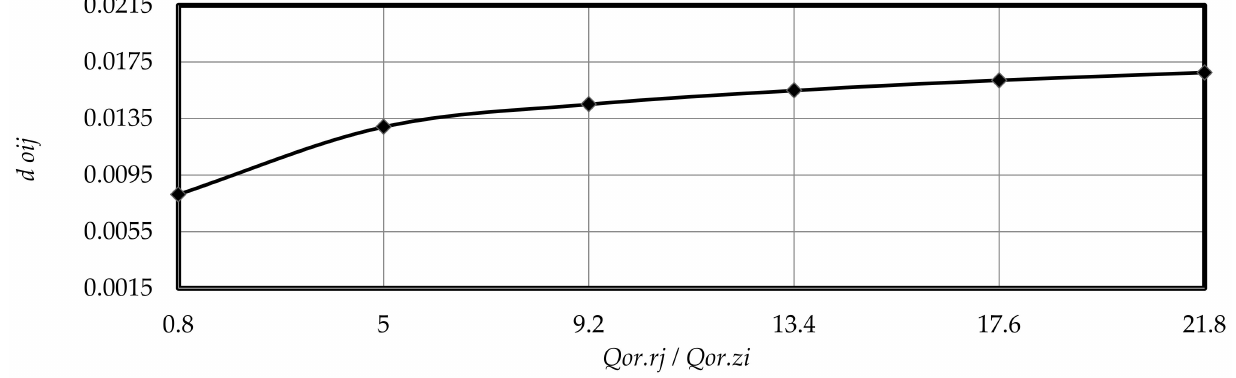
Figure 8. Graph of the change in trip distribution function of urban employers of service enterprises depending on the ratio of quantity of places of application of work in the zone of application of work to the quantity of places of application of labor in the zone of